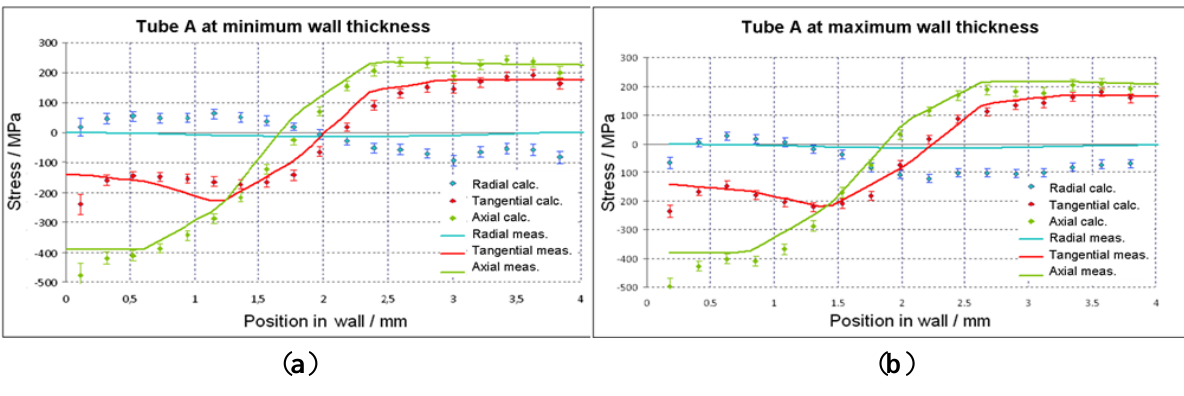
Figure 10. Distribution of residual stresses in tube A (without plug) at ( a ) maximum and ( b ) minimum wall thickness; dots: measurement, lines: FEM calculation.